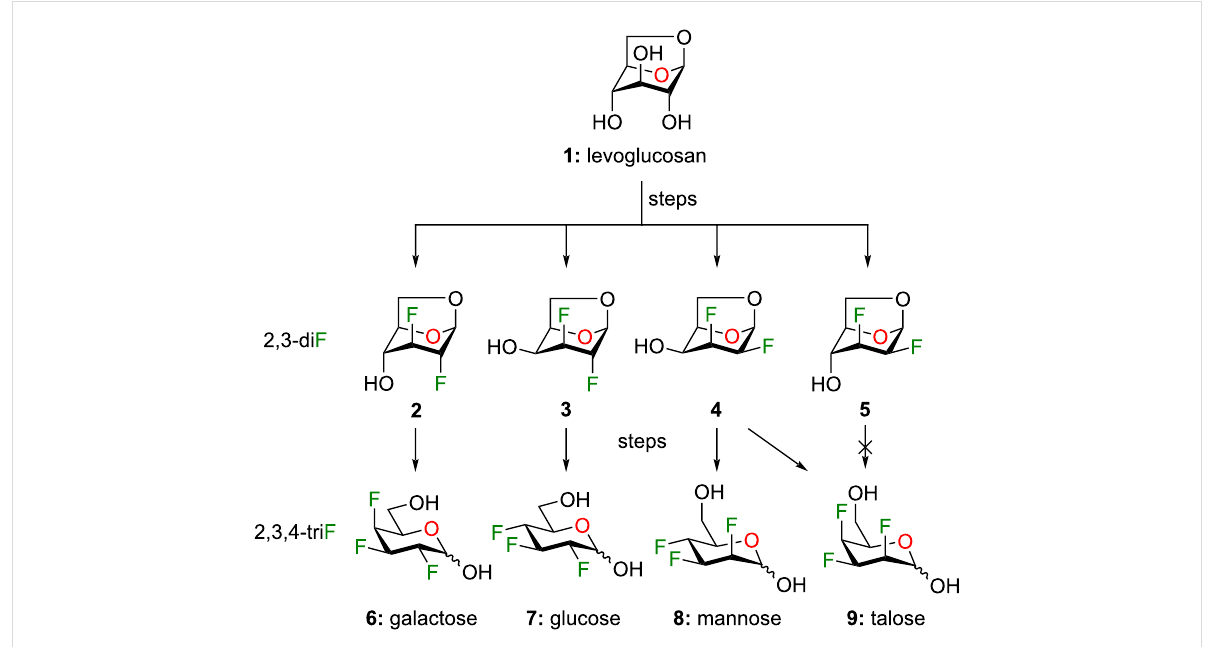
Figure 1: Previously described synthesis of 2,3,4-trifluorinated analogues of galactose 6 , glucose 7 , mannose 8 , and talose 9 from levoglucosan 1 .